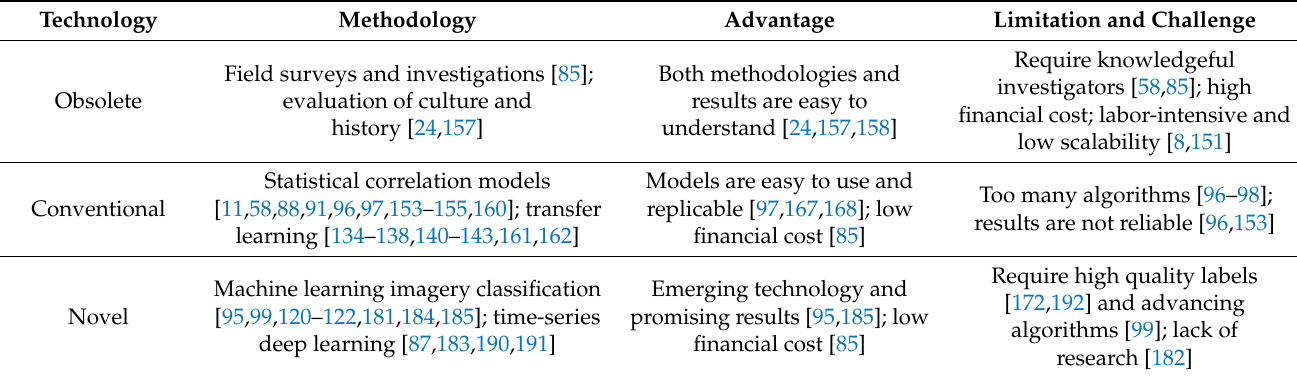
Table 1. Summarizing and comparing the strengths and weaknesses of generational technologies and methodologies for mapping urban poor and